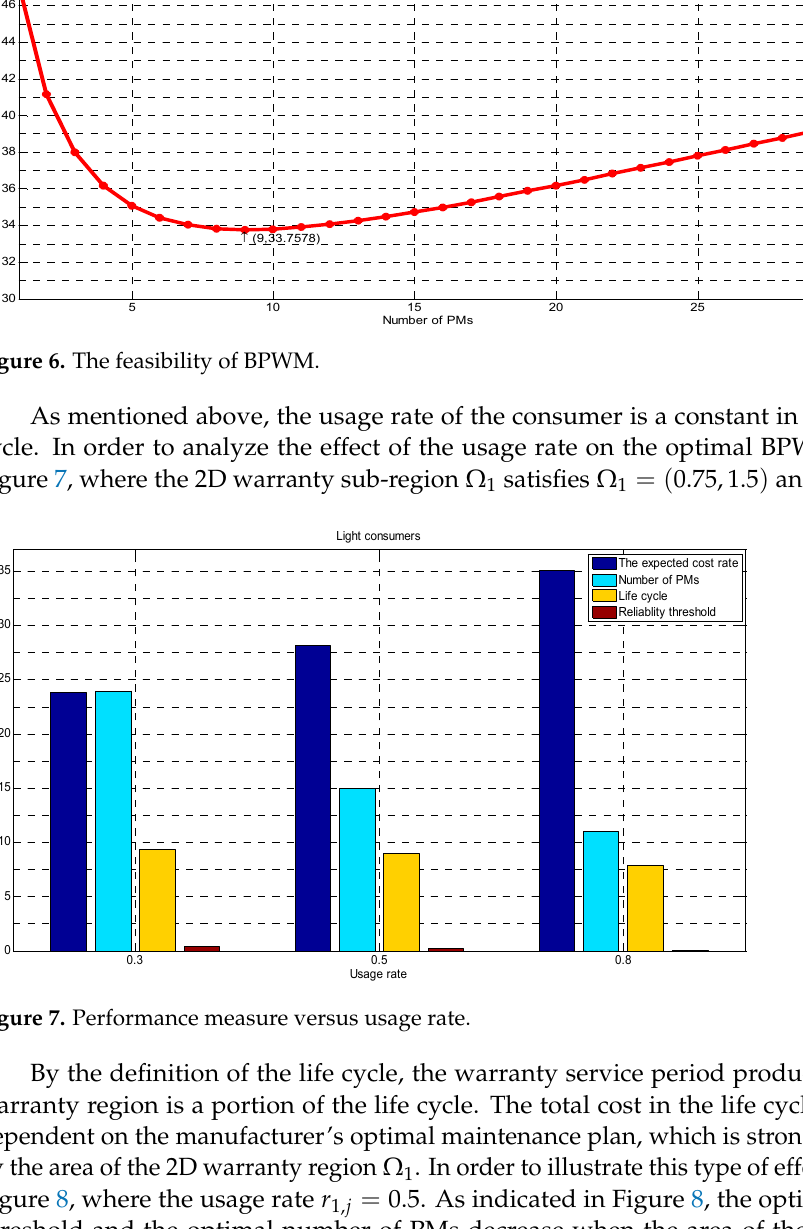
= . As indicated in Figure 8, the optimal